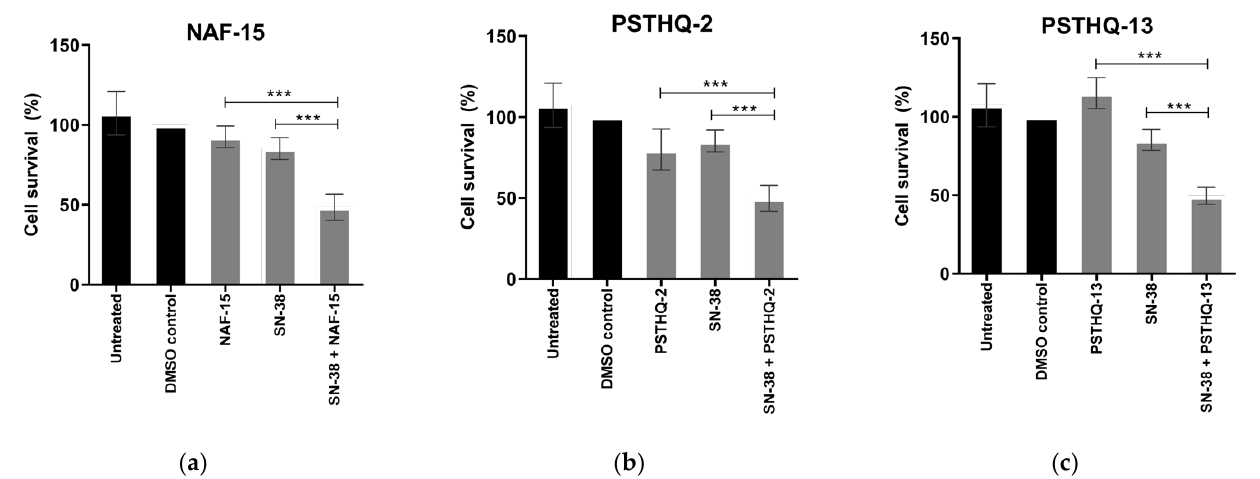
Figure 4. Cell survival after treatment with the TDP1 inhibitors NAF-15 ( a ), PSTHQ-2 ( b ), and PSTHQ-13 ( c ) in combination with the TOP1 poison, SN-38, for 72 h, in HeLa cells. All SN-38 containing samples contained 10 nM SN-38. DMSO control contained 0.5% DMSO, which is the same DMSO amount as in all drug containing samples. The TDP1 inhibitors have a final concentration of ( a ) 17.5 µM NAF-15, ( b ) 35 µM PSTHQ-2, and ( c ) 35 µM PSTHQ-13. Cell survival was measured by using PrestoBlue. All data were normalized to the DMSO control. *** Represents a p -value < 0.001.